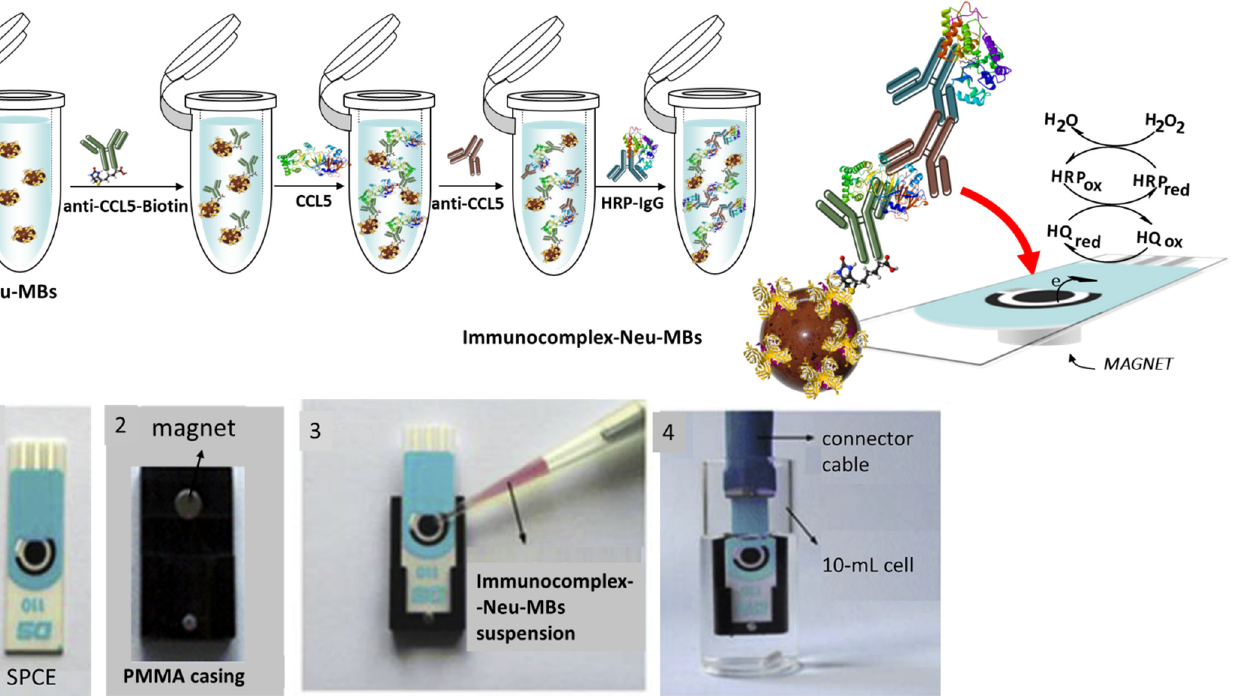
Figure 1. ( A ) Schematic display of the steps involved in the construction of the magnetically assisted im-munoplatform for CCL5 and the reactions providing the amperometric responses. ( B ) Homemade magnet holding block with an encapsulated neodymium magnet (2); addition of the immunocomplex–Neu–MBs suspension onto the electrode surface of SPCE (3); SPCE with 50 μ L of the magnetoimmunoconjugate immersed into a 10 mL electrochemical cell to perform the amperometric measurements.